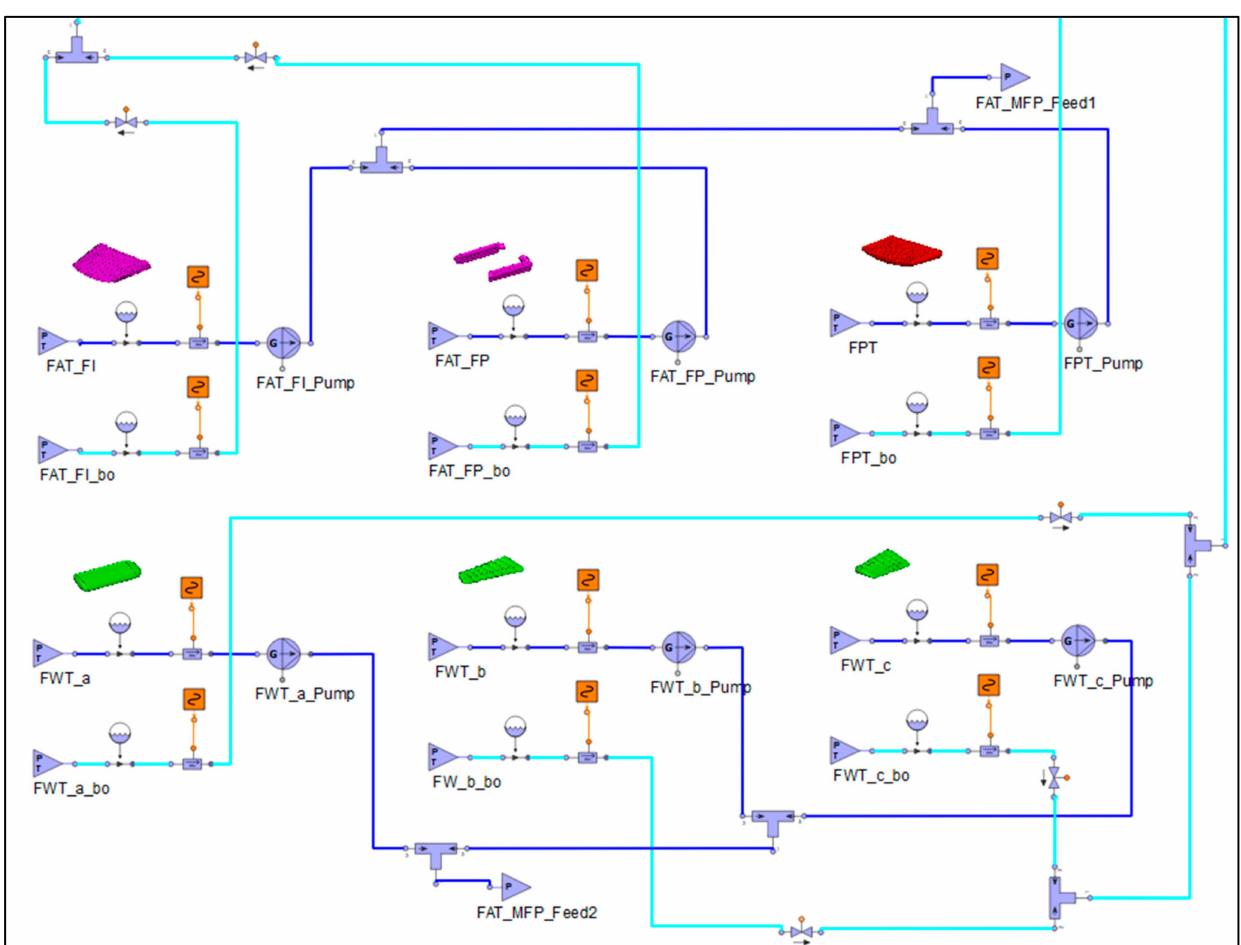
Figure 14. Front module, detail of auxiliary tanks.